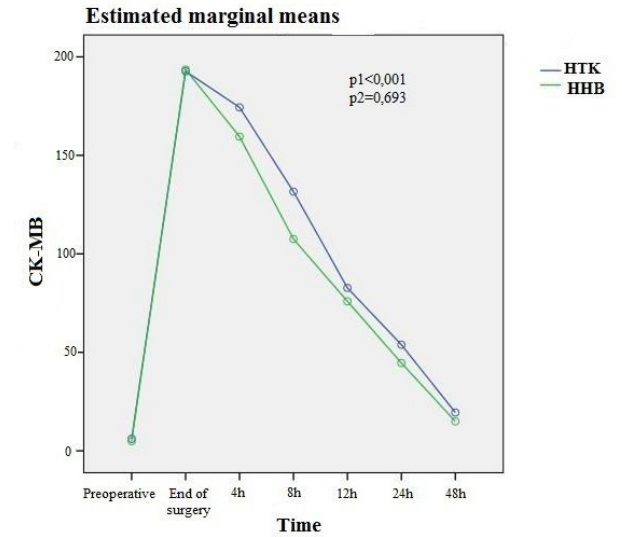
Fig. 1 – Variation of troponin in time (P1) and between groups (P2). HHB=hypothermic hyperkalemic blood; HTK=histidine-tryptophan-